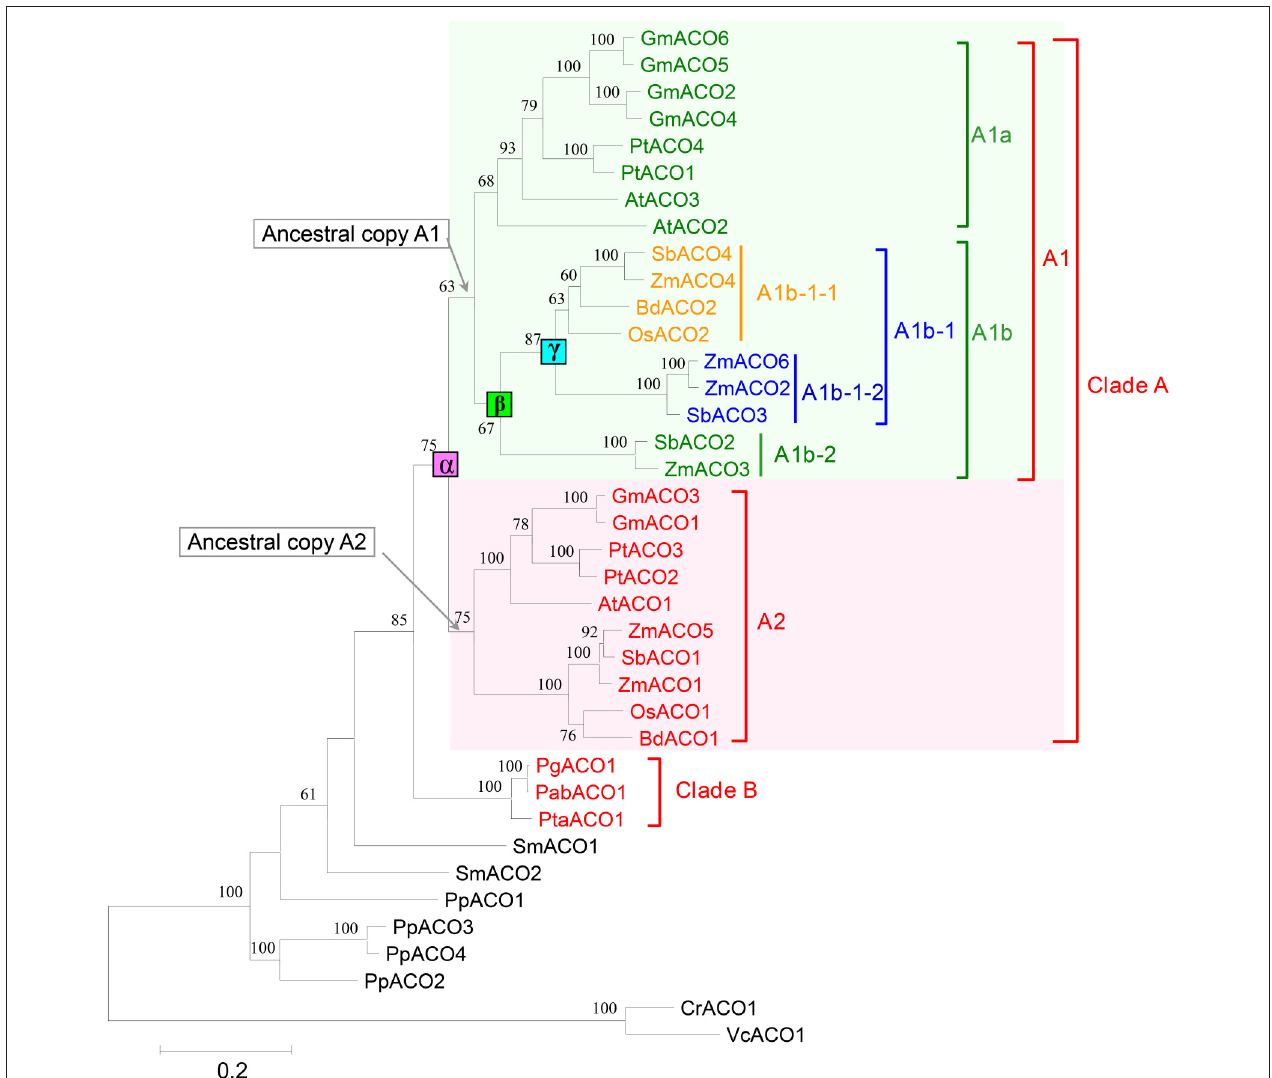
FIGURE 3 | Phylogenetic tree of 36 ACOs from 12 land plants. Squares indicate three duplication events, annotated with α , β , and γ , respectively. Only bootstrap values > 50% are shown.